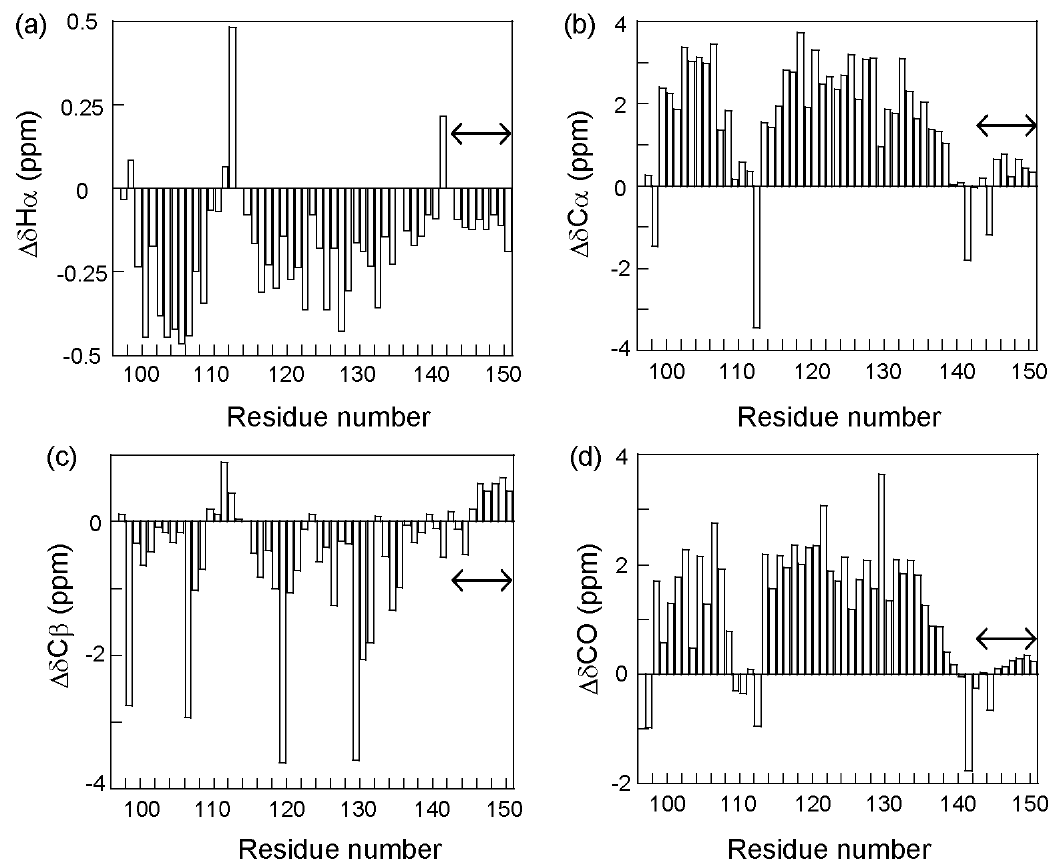
Figure 6. Secondary shifts of 1 H  (a) , 13 C  (b) , 13 C  (c) , and 13 CO (d) resonances of CHIBL  F. The residue numbers are given as the corresponding number in the full-length protein. Double arrows indicate the hexahistidine-tag